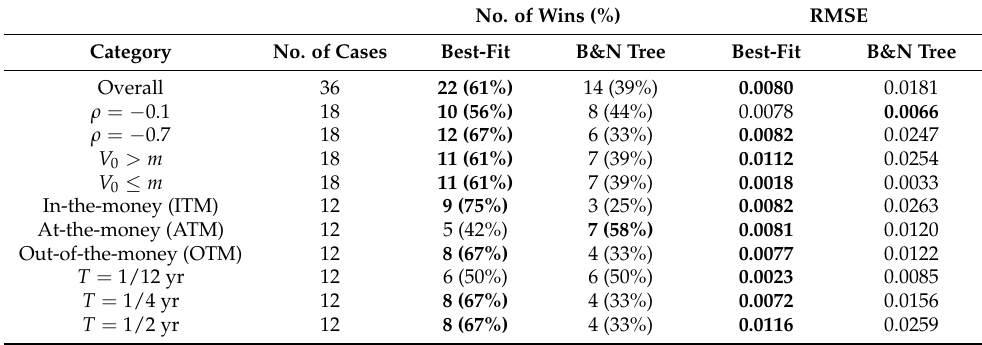
Table 7. Comparison summary of the results in Table